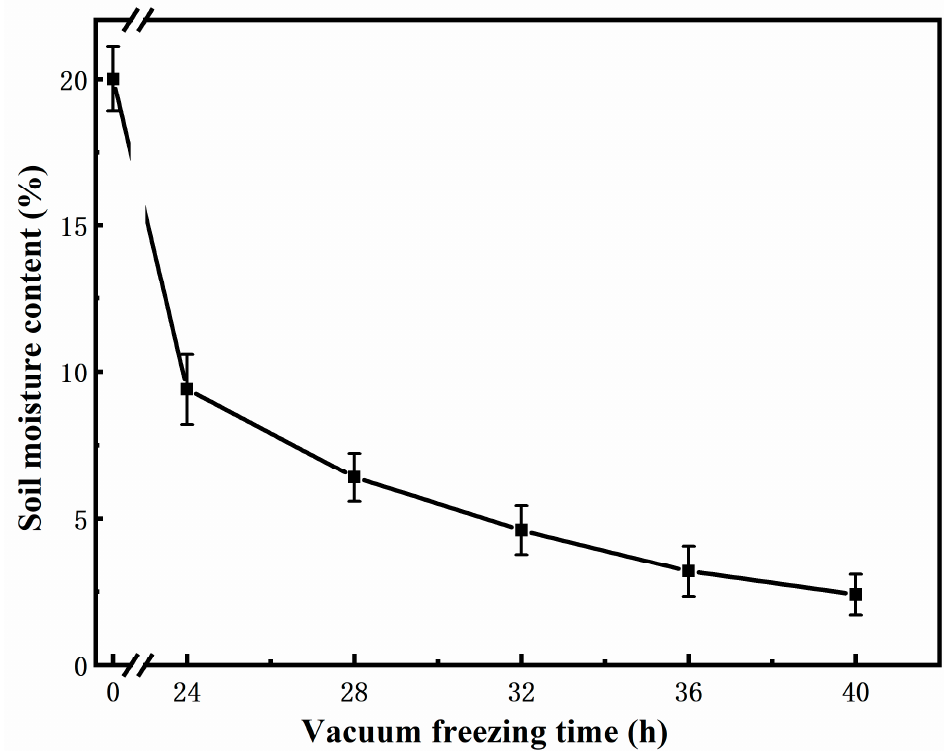
Figure 4. The influence of different vacuum freezing times on soil moisture content.